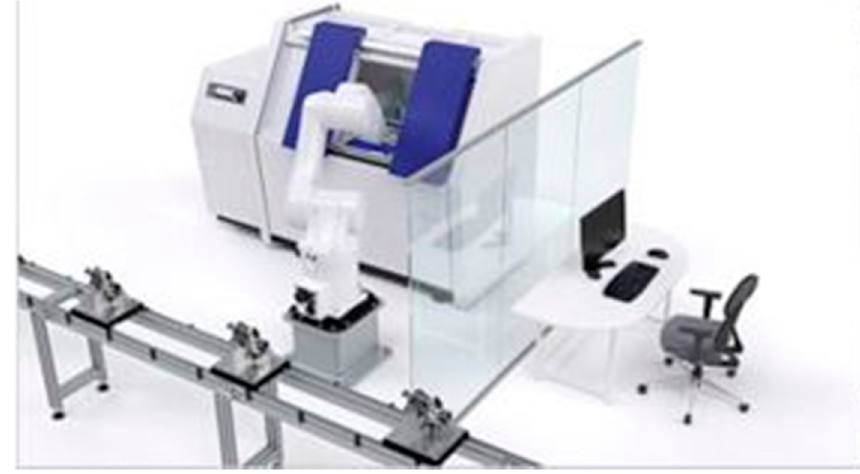
Figure 6. Robot and cabinet CT system for automated loading and unloading in a manufacturing line. Ref. [45] Reprinted from CIRP Annals, Volume 63, Issue 2, De Chiffre, Carmignato, Kruth, right 2021, with permission from Elsevier. Table 1. Examples of commercially available industrial X-ray CT systems with robotic automation .